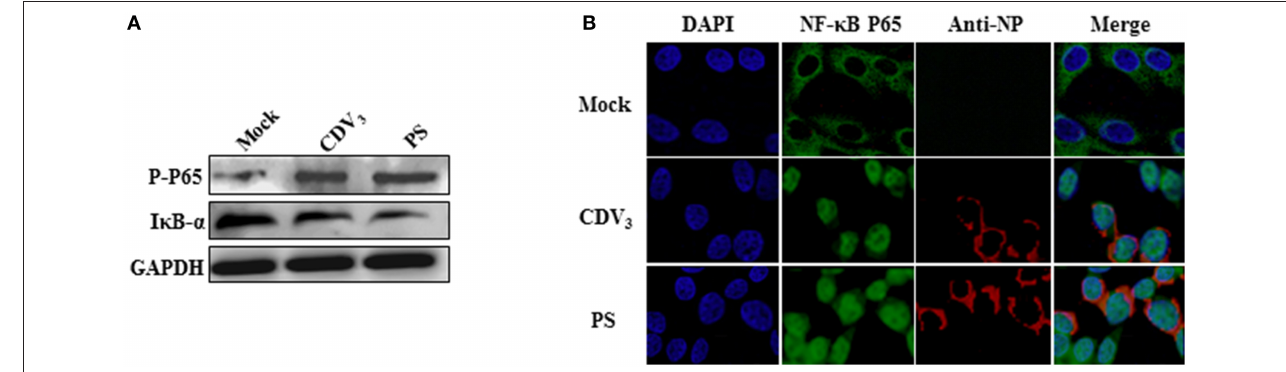
FIGURE 6 | CDV infection induces the phosphorylation and nuclear translocation of NF- κ B P65 and the degradation of I κ B- α proteins (A) CDV infection strengthened NF- κ B P65 phosphorylation and I κ B- α degradation. Mv.1.Lu cells were infected with 2 MOI PS or CDV 3 . At 24 hpi, cells were gathered for detecting the expression levels of phosphorylated NF- κ B P65 protein and I κ B- α protein. (B) CDV infection facilitated NF- κ B P65 nuclear translocation. Mv.1.Lu cells were infected with 2 MOI PS, CDV 3 or mock-infected. At 24 hpi, the cells were fixed and incubated with rabbit polyclonal antibody specific to mink NF- κ B P65 and mouse monoclonal antibody specific to CDV N protein, then incubated with FITC-labeled goat anti rabbit IgG and Cy3-labeled goat anti mouse IgG, respectively. Cell nuclei were stained by DAPI. The fluorescent images were analyzed under a confocal microscopy (Leica,